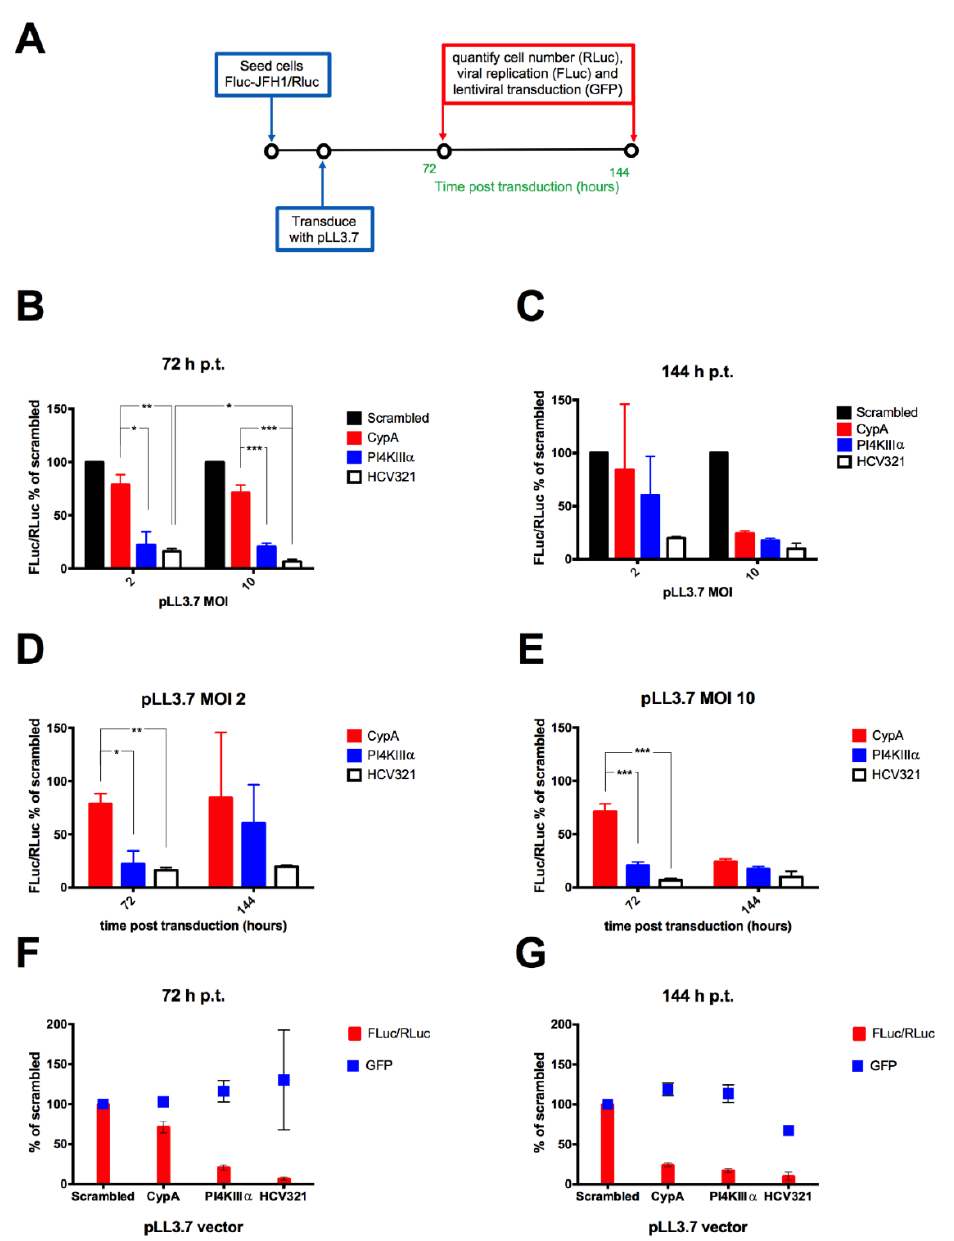
Figure 5. MOI-dependent inhibition of HCV replication as mediated by single miRNA-expressing pLL3.7 vectors. ( A ) 2 × 10 4 cells / cm 2 and 1 × 10 4 cells / cm 2 of FLuc-JFH1 / RLuc cells were seeded in 24-well plates, cultured at 37 ◦ C in a humidified incubator for further 24 h, and transduced at an MOI of 2 or of 10 TU / cell with pLL3.7-derived lentiviral particles encoding single shRNAs targeting the indicated sequences for 72 and 144 h, respectively. At the indicated time points p.t., cells were lysed and processed for fluorimetric detection of transduction efficiency (GFP) and luminometric detection of cell number (RLuc) and HCV replication (FLuc), allowing to calculate the relative HCV replication indicated by the FLuc/RLuc ratio. The FLuc/RLuc ratio relative to cells transduced with the indicated lentiviruses is shown at 72 ( B ) and 144 ( C ) hours p.t., and for MOI of 2 ( D ) and MOI of 10 ( E ), expressed as a percentage of the mean values obtained for cells transduced with pLL3.7 encoding for a non- targeting shRNA (Scrambled). The latter, relative to cells transduced with MOI of 10 is also compared to the GFP/RLuc ratio expressed as percentage of mean values obtained for cells transduced with pLL3.7 encoding for a non-targeting shRNA (Scrambled) at 72 ( F ) and 144 ( G ) hours p.t. Data are the mean + standard error of the mean relative to three independent experiments. * = p ≤ 0.05; ** = p ≤ 0.005; *** = p ≤ 0.0005.